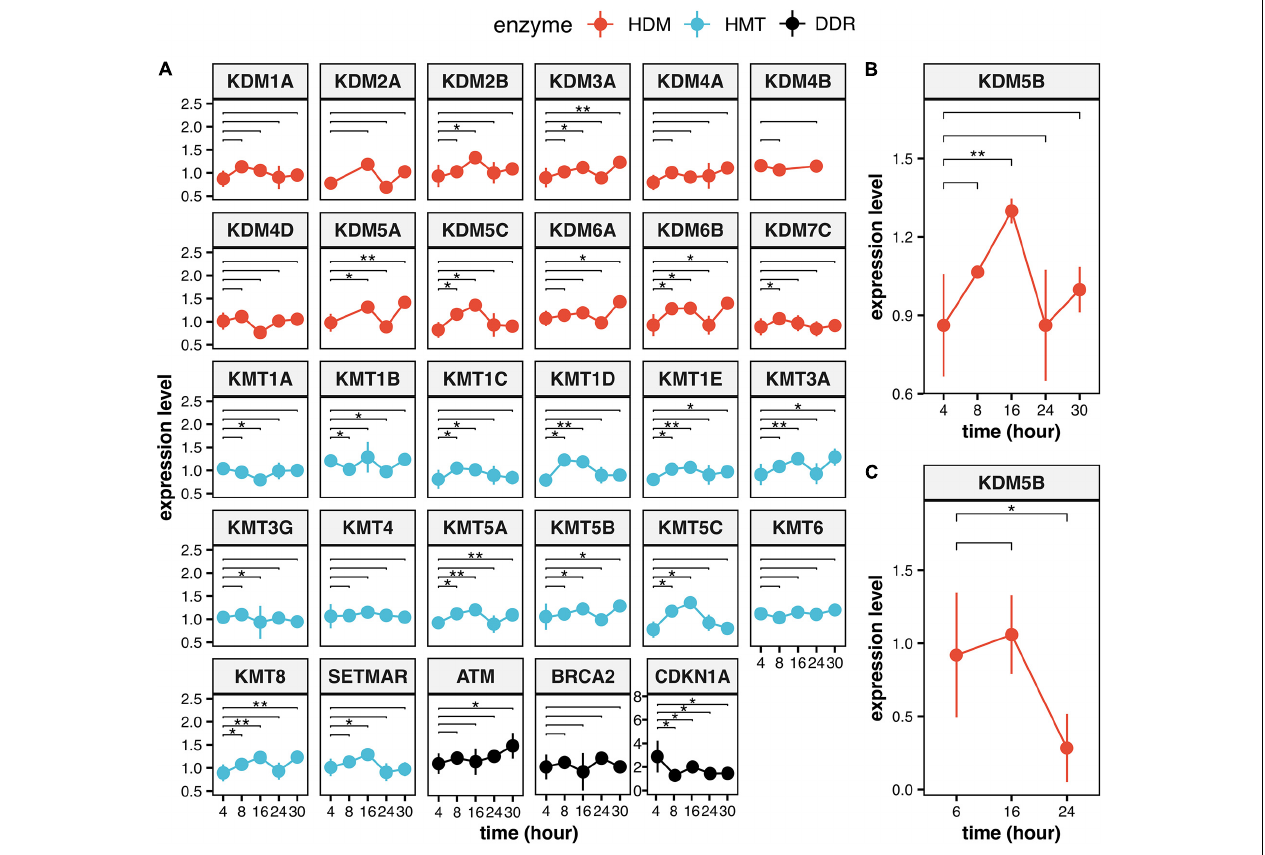
FIGURE 4 | Expression levels of the HMTs and HDMs in response to ionizing radiation. (A) Time course of the modulation of all the HMTs and HDMs which are reported on Supplementary Table 1 and of the DDR genes ATM, BRCA2, and CDKN1A after particle irradiation. Data for KDM5B are reported for particle irradiation (B) and for X-ray (C) . Statistical analysis of experimental data was performed using analysis of variance (ANOVA) followed by multiple comparison Tukey’s test. The data was retrieved from the NCBI Gene Expression Omnibus (GEO) public repository from these datasets: GSE23901, GSE23903, GSE32091, GSE21059, (Ghandhi et al., 2011) GSE23807, GSE30240 (Rashi-Elkeles et al., 2011). All statistical analysis was carried out using native functions of R language version 3.6.3. Expression levels reported are the Log2(IR/control) values. ** P < 0.01 and * P <